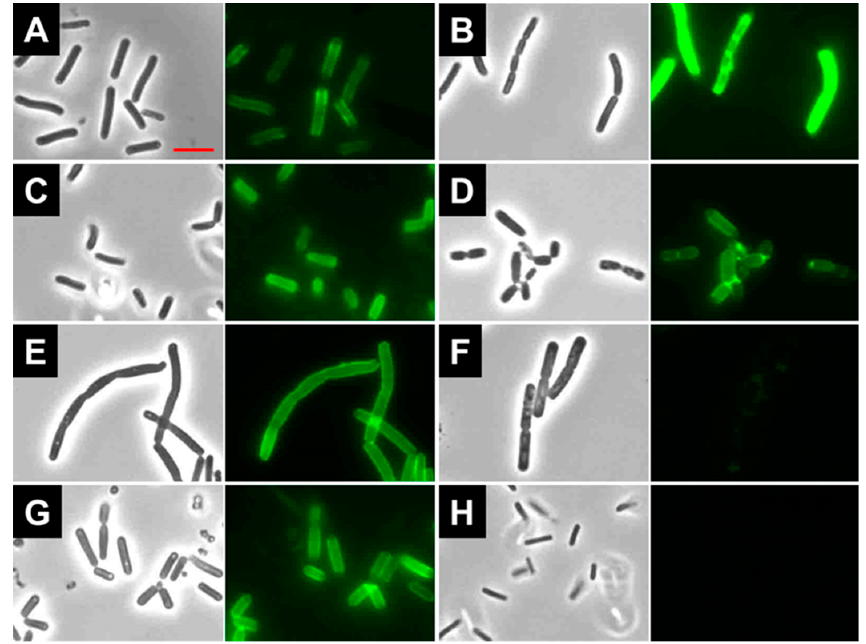
Figure 5. The CWB of LysBC17 directs GFP (GFP-CWB) to the surface of bacteria. Selected bacterial cells and GFP-labeled LysBC17 CWB were mixed together, washed, and viewed by microscopy per the Methods. 1000× phase-contrast images (left panels) are shown with their corresponding fluorescent images (right panels). Exposure time for all fluorescent images was 100 ms. ( A ) B. cereus ATCC